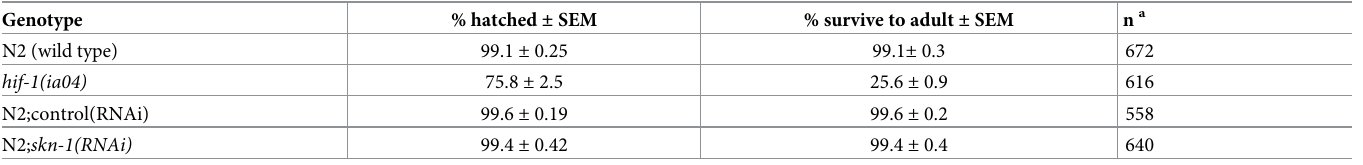
Table 2. Relative requirements for skn-1 and hif-1 : Survival in 0.5% oxygen. Genotype